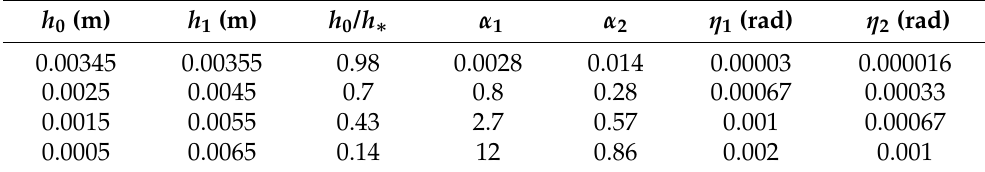
Table 1. Parameters of the thickness used in the